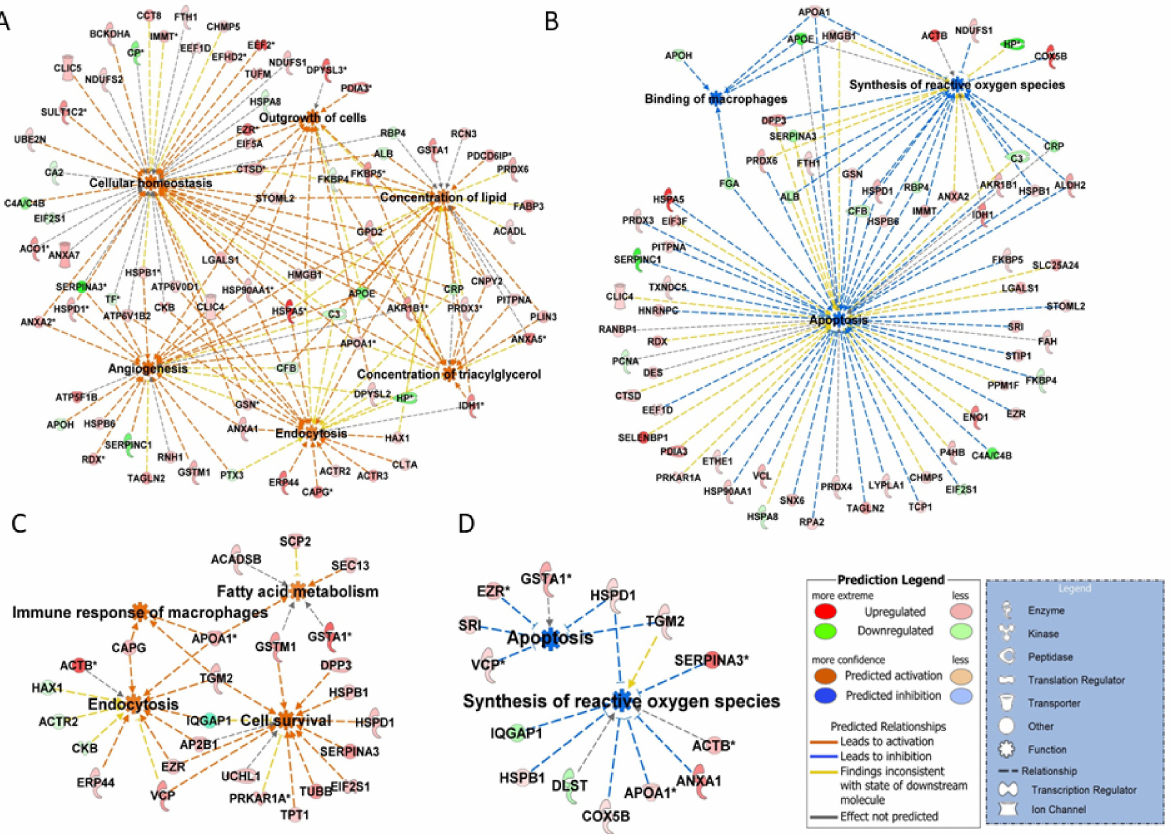
Figure 2. IPA disease and function analysis of differentially abundant proteins. Top functions ranked in accordance to z-score ( − 2.0 ≥ z-score ≥ 2.0) with luteal development from Day 3 to Day 9 of estrous showed ( A ) enrichment of functions: cellular homeostasis, concentration of lipids and triacylglycerol, endocytosis and angiogenesis, and ( B ) inhibition of functions: apoptosis, synthesis of reactive oxygen species, and binding of macrophages. Maintenance of luteal function from Day 9 to Day 12 showed ( C ) enrichment of functions: fatty acid metabolism, cell survival, endocytosis, and immune response of macrophages and ( D ) inhibition of functions: apoptosis and synthesis of reactive oxygen species. Red and green colors depict an increase or decrease, respectively, in abundance of the proteins associated with a